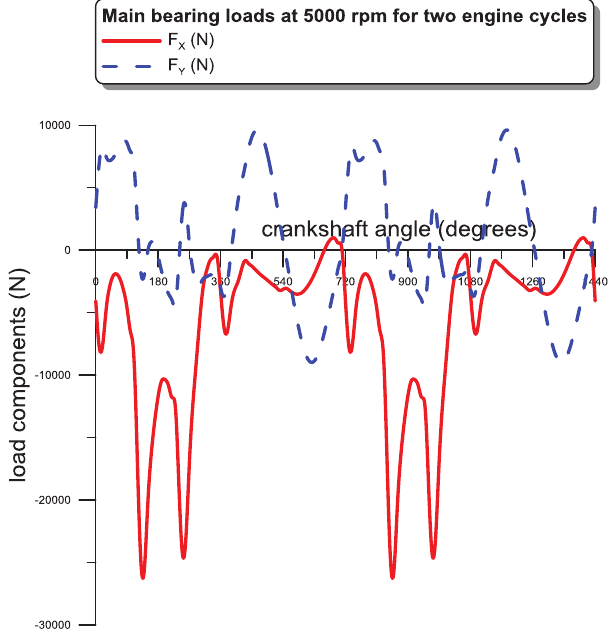
Fig. 6. Cartesian representation of dynamic loading on the Paranjpe ’ s main bearing